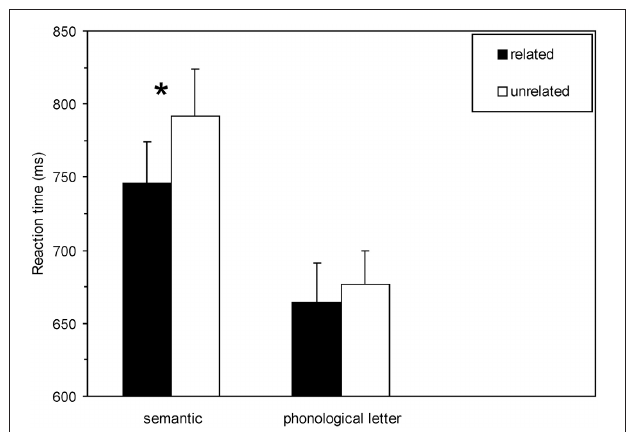
FIGURE 3 | Experiment 2. Mean lexical decision latencies ( n = 22) as a function of semantic relatednessand induction task. Related = semantically related prime target pairs; unrelated = semantically unrelated prime target pairs. Please note the significant interaction ( p < 0 . 01) between induction task and semantic relatedness due to attenuated priming subsequent to the phonological letter induction task compared to the semantic induction task. The asterisk indicates significant priming effects ( p < 0 .